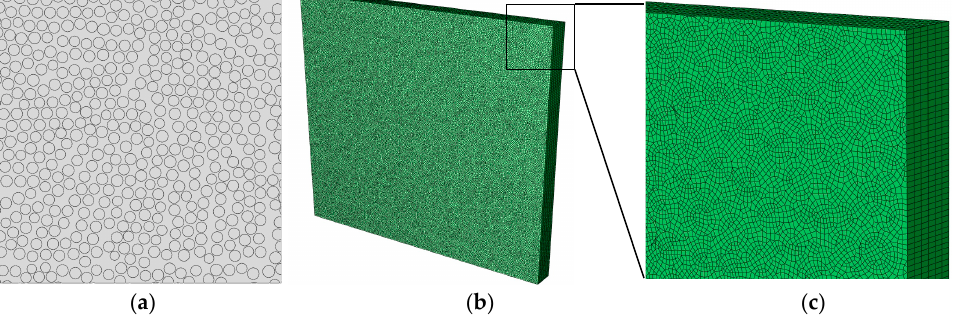
Figure 8. ( a ) Random RVE for composite with fiber volume ratio 60%; ( b ) and ( c ) 3D finite element mesh for the microstructure of ( a ).